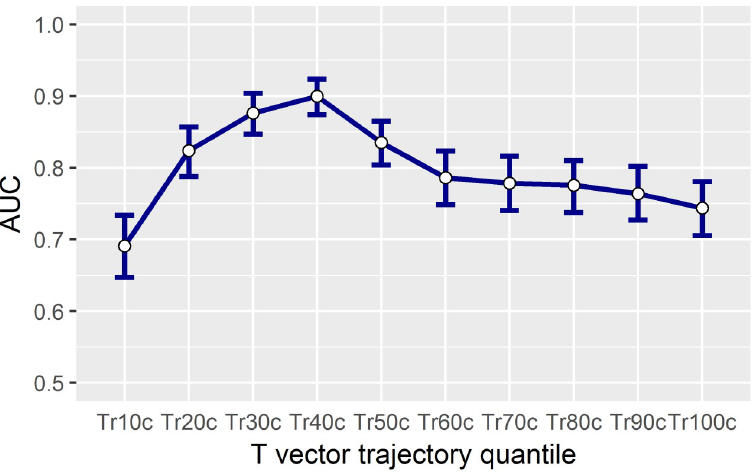
Fig 8. Performance of separating pure hERG/iKr current block from multichannel block based on individual T vector trajectory quantiles. Separation performance between group I and group II (see section 3.5) is measured by the area under the receiver-operating curve (AUC) with its 95% confidence intervals. The T vector trajectory quantiles Tr10c to Tr100c are corrected for heart rate. Best separation is observed for the 40% quantile Tr40c.